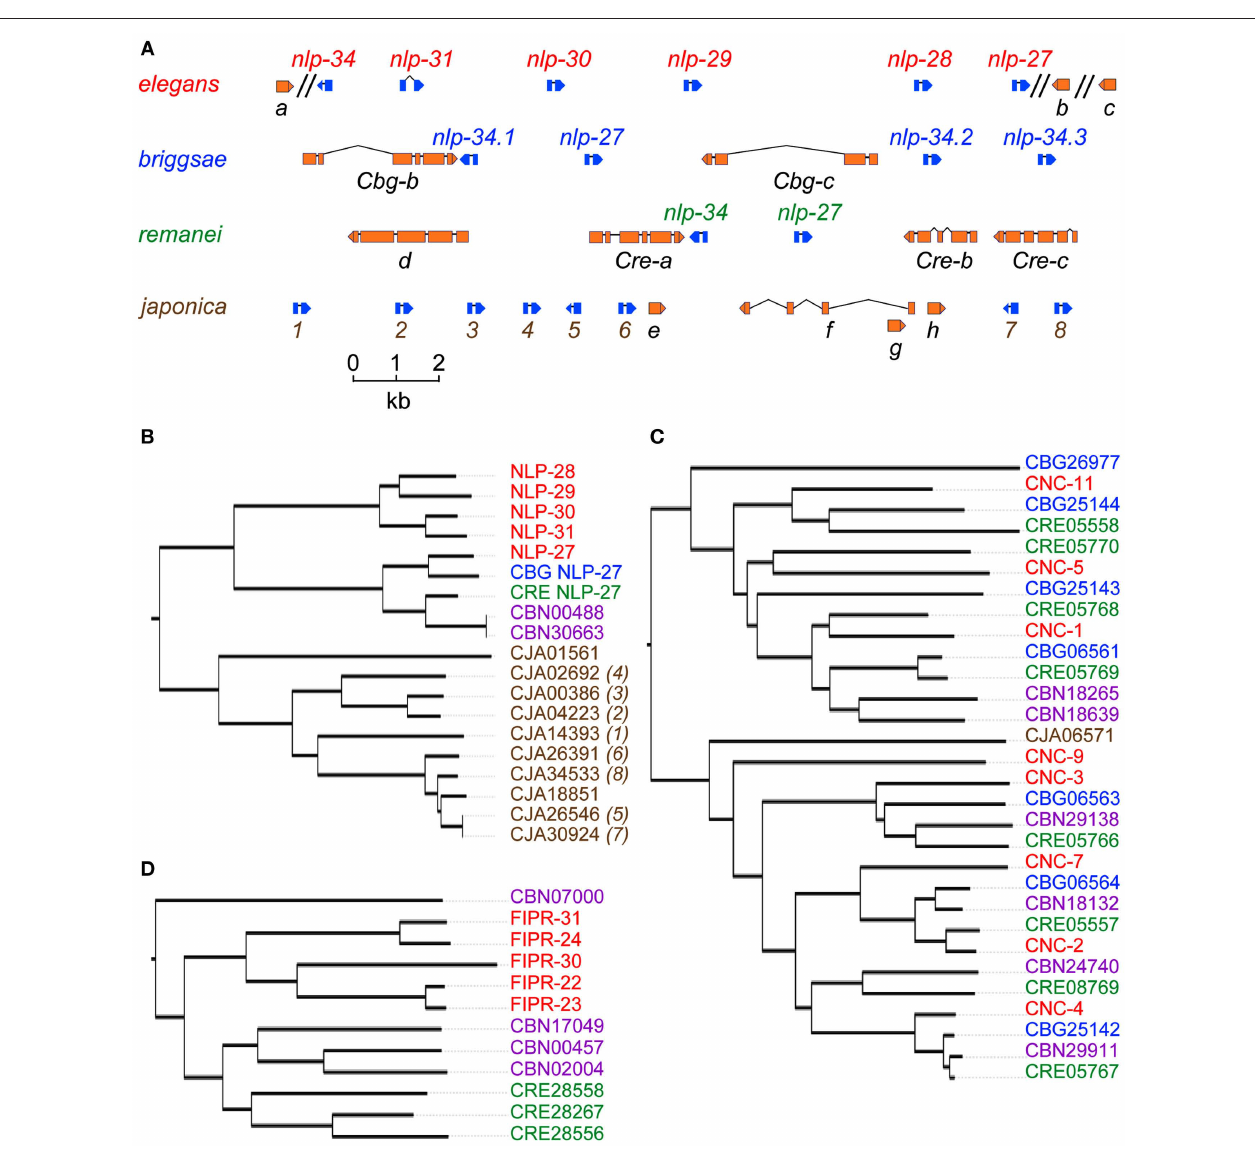
members of the NLP (B) , CNC (C) , and FIPR (D) family peptides, including homologs in C. brenneri (CBN). A distance matrix analysis was performed using the alignment program clustalw2 to generate a guide tree via pairwise and subsequent multiple sequence alignment. This guide tree was then used to produce a true phylogenetic tree that was loaded into the Interactive Tree Of Life v2 software suite (Letunic and Bork, 2011). Partial rooted trees were extracted that corresponding to interesting features within the complete FIP/ FIPR/NLP/CNC tree. For the non- elegans peptides, with the exception of CBG NLP-27 and CRE NLP-27, the corresponding gene identifier is given. The numbers in brackets for the C. japonica gene names match the corresponding genes in (A)